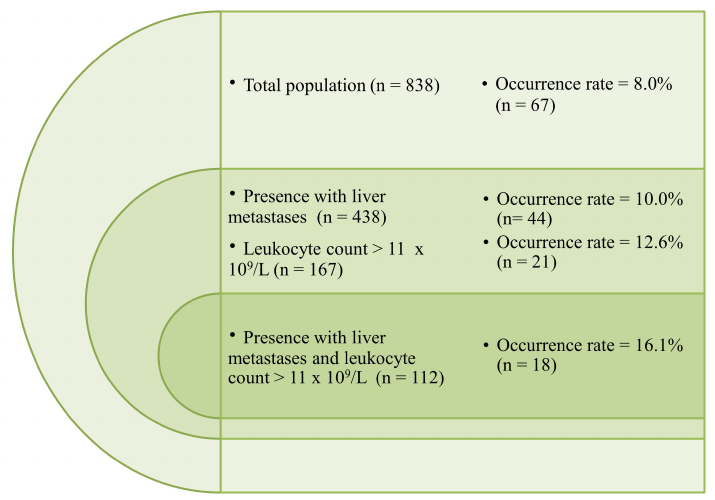
Figure 3. Distribution of VTE according to the risk factors presented by patients.